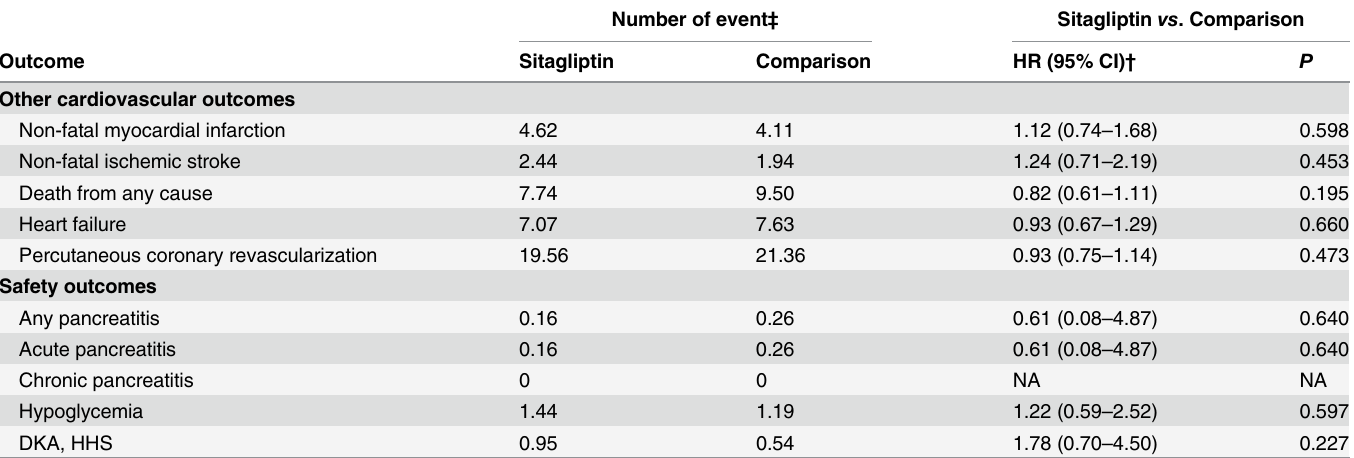
Table 4. Secondary outcomes (all